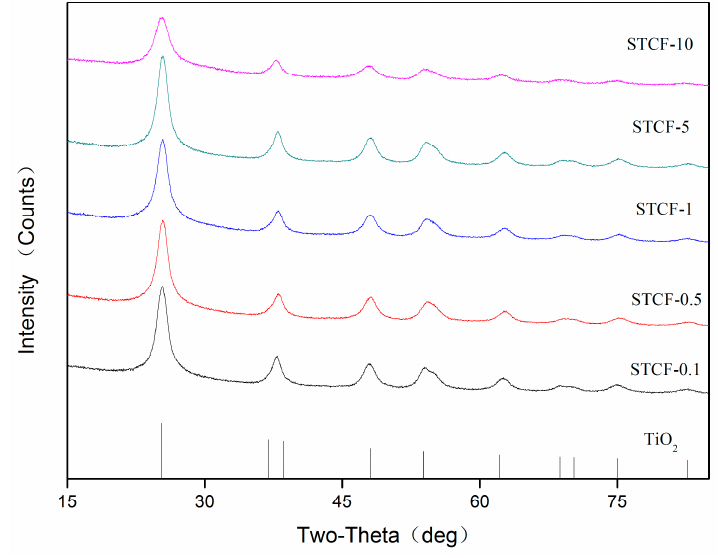
Figure 7. XRD patterns of STCF with different Fe 3+ doping.